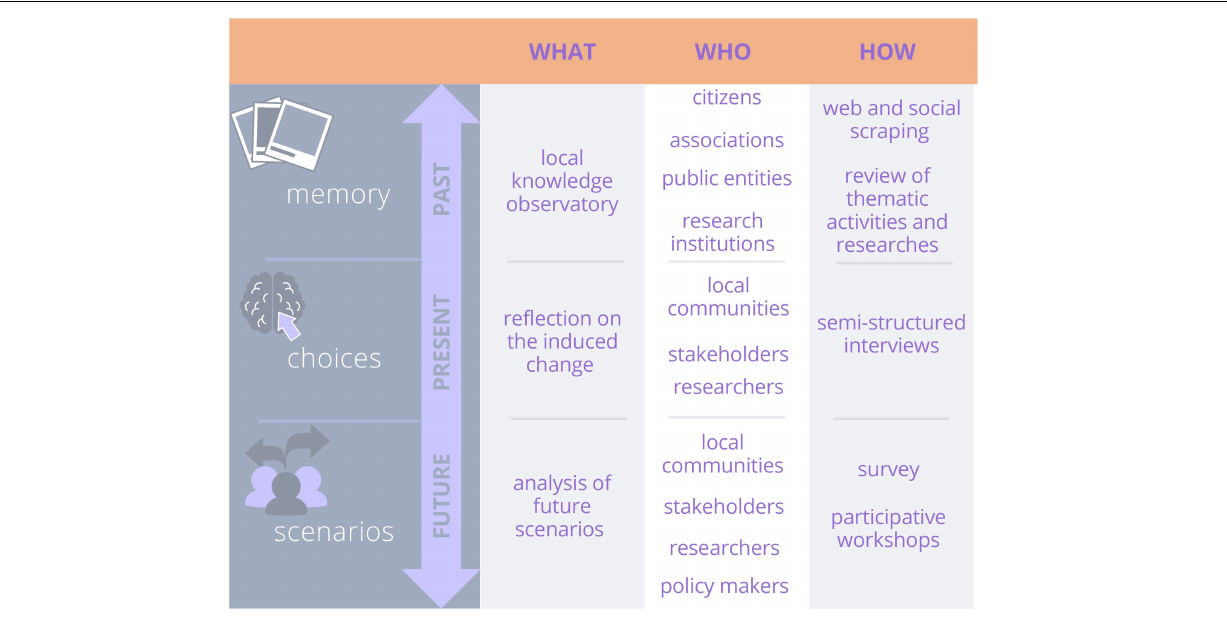
FIGURE 2 | Activities aimed at including stakeholders’, researchers’, and citizens’ visions and knowledge in the SNAPSHOT overall picture. The schema defines the three main dimensions explored and, for each of them, indicates the subjects involved and the methods of investigation